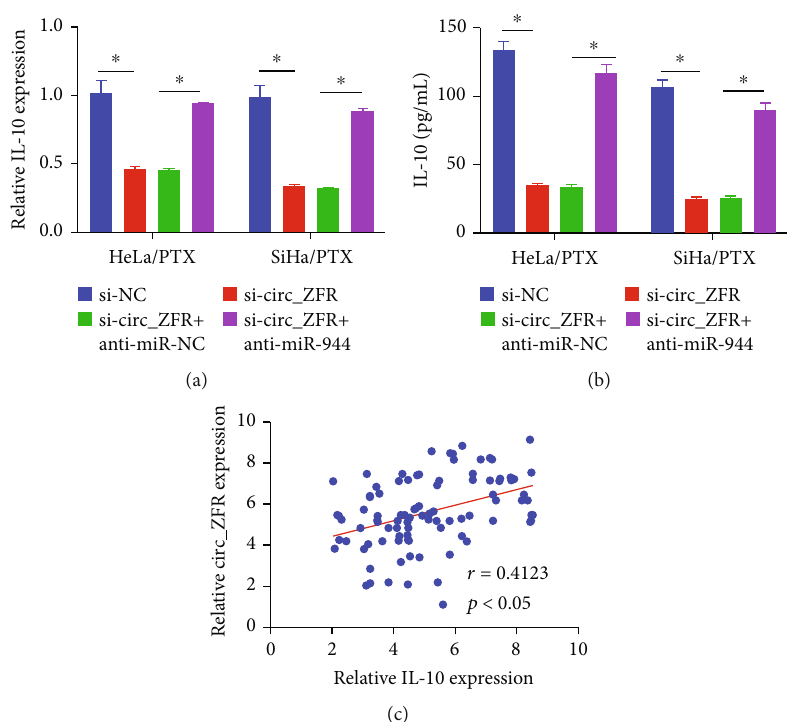
Figure 5: The circ_ZFR knockdown reduced the expression level of IL-10 via miR-944 sponging. (a, b) The data obtained from qRT-PCR and ELISA assay to detect the IL-10 expression. (c) The association between IL-10 and circ_ZFR. ∗ p < 0 : 05